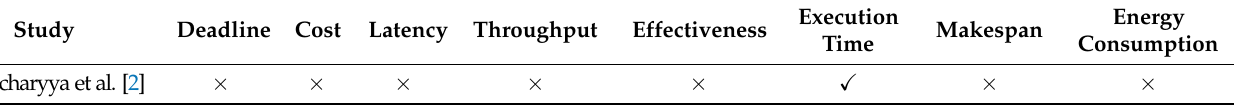
Table 9. Analysis of articles in terms of evaluation parameters in smart home